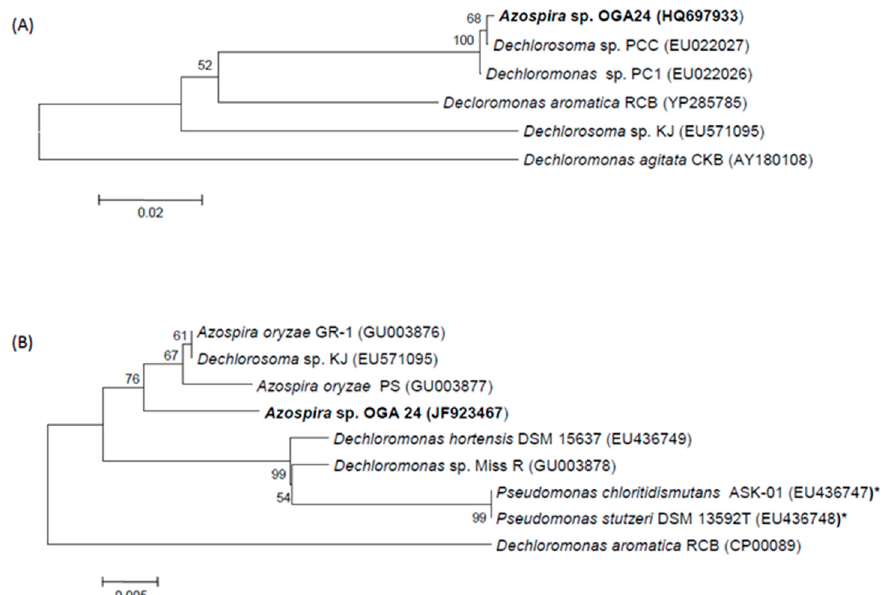
Figure 6. Phylogenetic analysis of perchlorate reductase and chlorite dismutase. Relationship of PcrA ( A ) and Cld ( B ) of OGA 24 strain (bold) with correspondent amino acids sequences of related Proteobacteria are indicated. In ( B ) both PRB and CRB (*) are reported. For the analysis, only coding sequences present in database > 2000 bp and > 800 bp for PcrA and Cld, respectively, were considered. Bootstrap values (expressed as percentages of 1000 replications) >50 are shown.